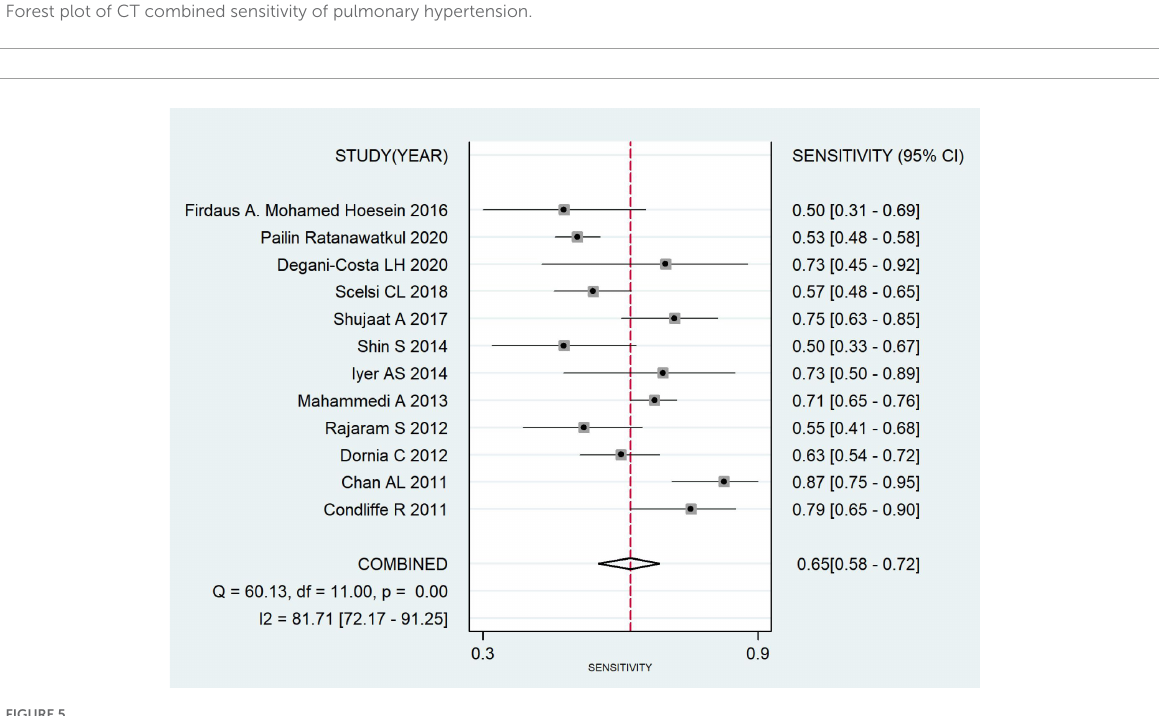
FIGURE5 Forest plot of pulmonary hypertension diagnosed with specificity by